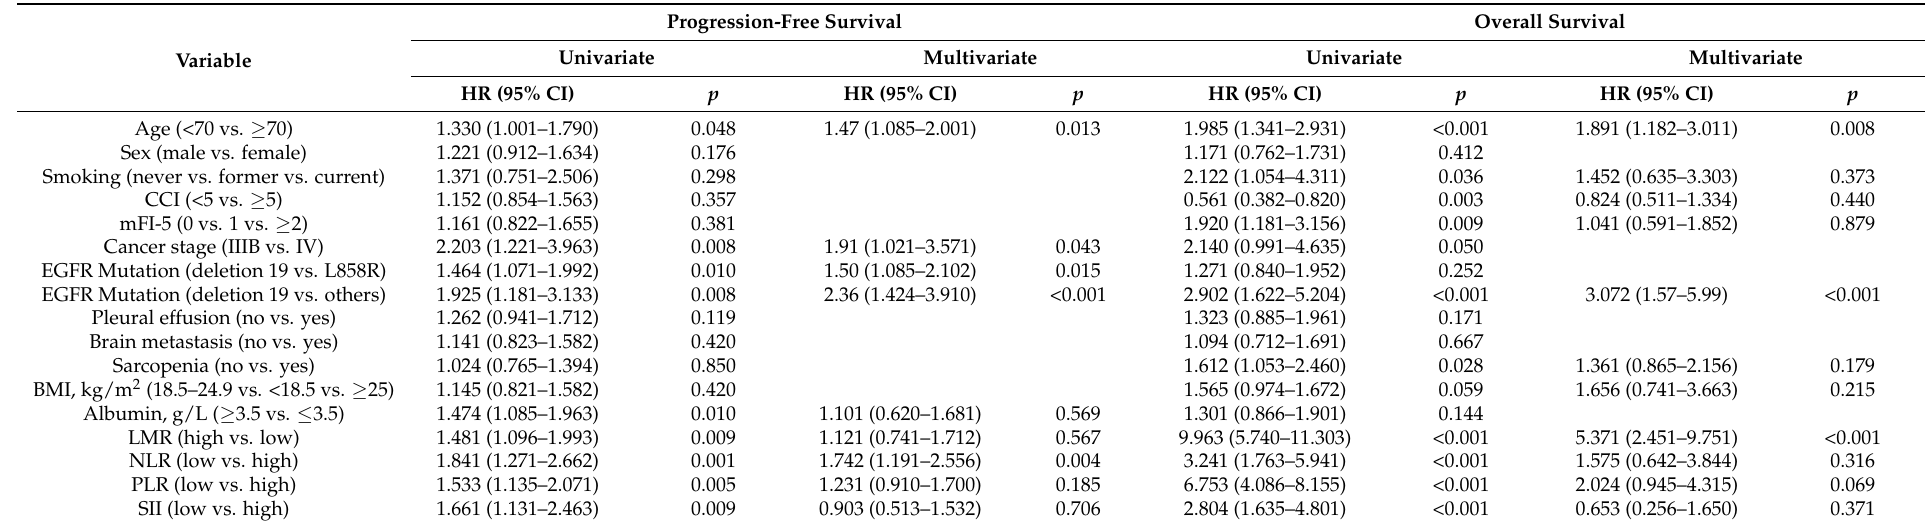
Table 4. Univariate and multivariate Cox regression analyses for the prediction of survival outcomes.